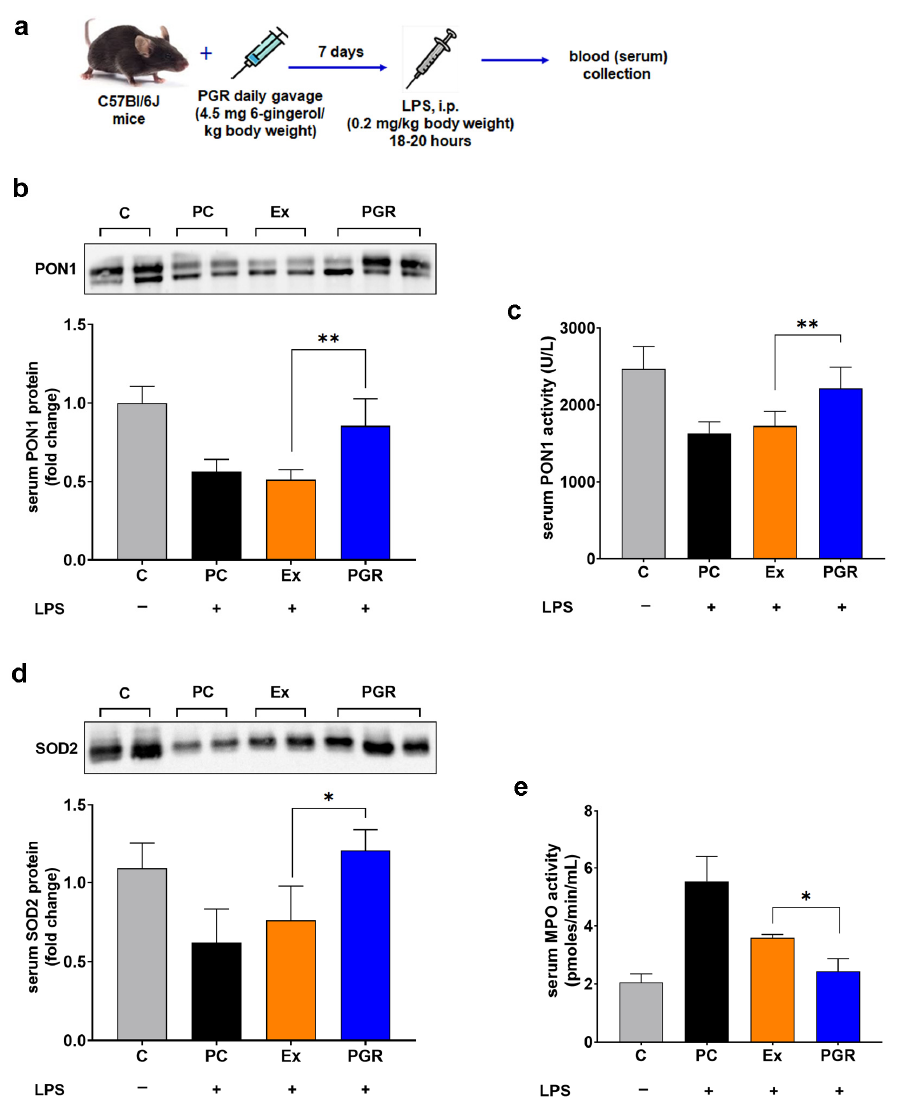
Figure 7. Experimental design for the assessment of the antioxidant effects of PGR 0.5:0.5:1 in vivo ( a ). Levels of the antioxidant enzyme paraoxonase 1 (PON1) protein ( b ) and activity ( c ), superoxide dismutase 2 (SOD2) protein ( d ) and pro-oxidant enzyme myeloperoxidase (MPO) activity ( e ) in the sera of mice who received PHYTOGINROSA (PGR), a mix of extracts (Ex) and phosphatidylcholine (PC) before the induction of systemic inflammation. The results are presented as means ± SD; *p < 0.05, **p < 0.01 for PGR versus Ex; C—control animals.